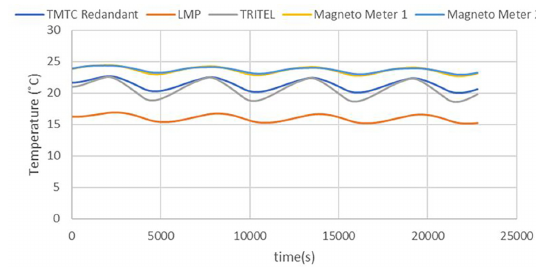
Fig. 10: Equipment temperature change on panel three.